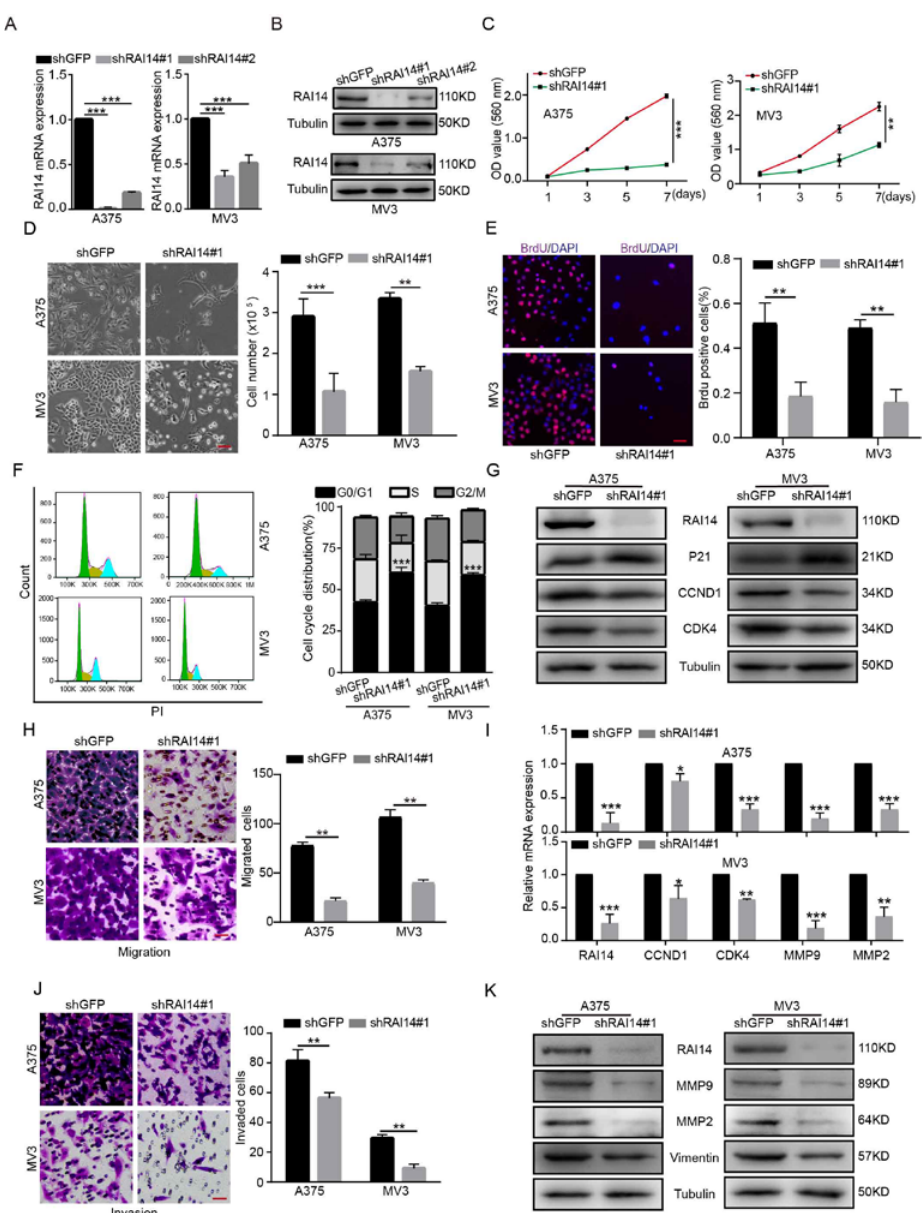
Figure 2. RAI14 knockdown inhibited the cell proliferation, migration and invasion of melanoma cells. ( A , B ) The knockdown efficiency of RAI14 was detected by Western blot and qRT-PCR. ( C ) Cell viability was detected by MTT assay after knockdown of RAI14. ( D ) Microscopic observation and cell-counting assays were used to detect the proliferation of melanoma cells. Scale bar = 50 μm. ( E ) DNA synthesis capacity was examined by BrdU assay after RAI14 was knocked down. Scale bar = 50 μm. ( F ) Flow cytometry assays were performed to detect the effect of RAI14-knockdown on the cell cycle. ( G ) The expression of G1 cell-cycle regulatory protein was detected after RAI14 knockdown. ( H , J ) Transwell assay was performed to detect the effect of RAI14 knockdown on cell migration and invasion. Scale bar = 50 μm. ( I ) The effects of RAI14 knockdown on the mRNA expression levels of cell-cycle-related genes and EMT-related genes were investigated by qPCR experiments. ( K ) EMT related-proteins were detected in RAI14 knockdown cells and control cells. The data were expressed as mean ± SD. Student’s t test and One-way ANOVA were performed to analyze significance. * p < 0.05, ** p < 0.01, *** p < 0.001.